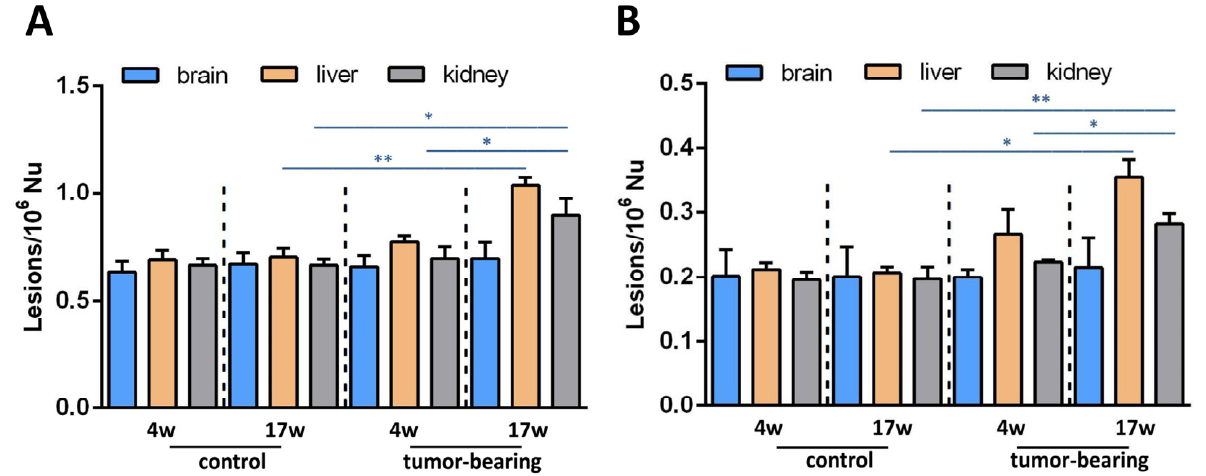
Figure 7. ( A ) cPu levels and ( B ) 8-oxo-dA levels in the brain tissue of control SCID and tumor-bear- ing SCID mice compared with previous tissue-specific patterns from the liver and the kidney [37] by isotope dilution liquid chromatography-tandem mass spectrometry * ( p < 0.05), ** ( p < 0.01).